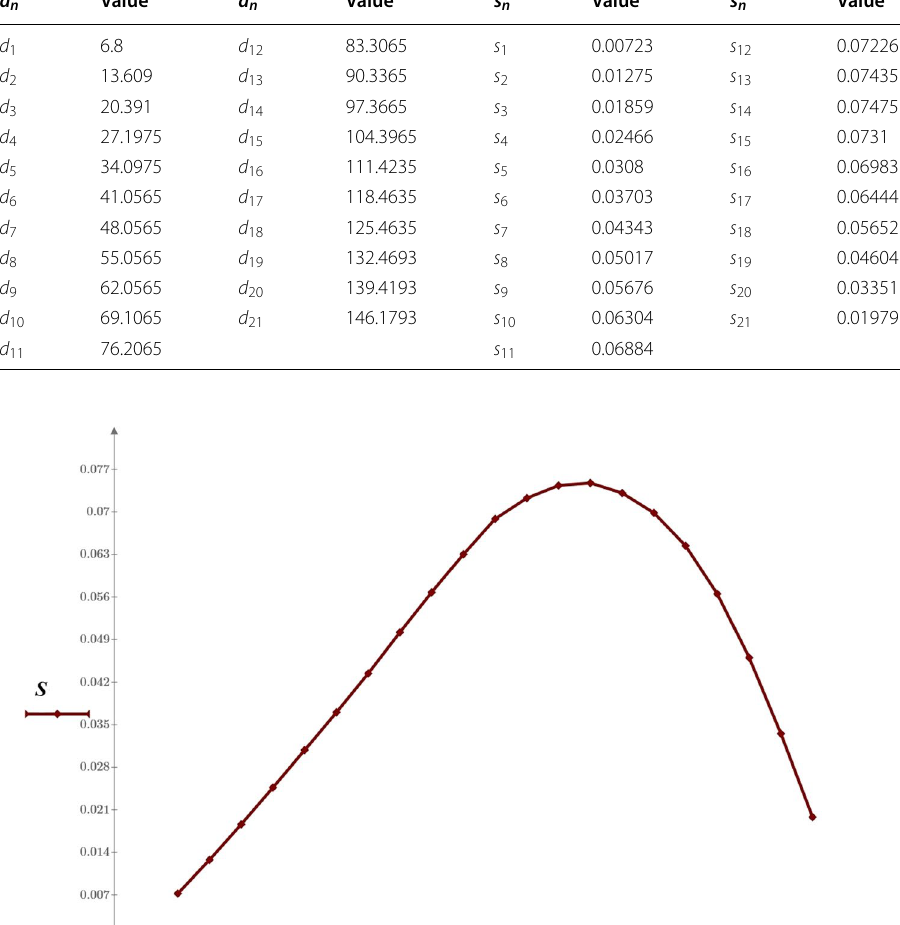
Table 2 The values of distances d n and coupling coefficients s n corresponding to design geometry d n